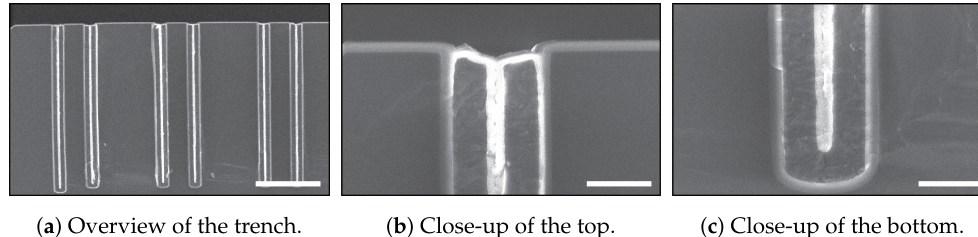
Figure 2. SEM images of the TASCT trenches after keyhole closure. This was achieved by etching the poly-Si at the wafer’s surface and closing the keyholes by dry thermal oxidation of poly-Si at 1100°C. In ( a ), the full trench is shown, in ( b ), a close-up at the top of the trench is shown, and in ( c ), a close-up at the bottom is shown [11]. The scale bar in ( a ) is 20µm, and in ( b , c ) it is